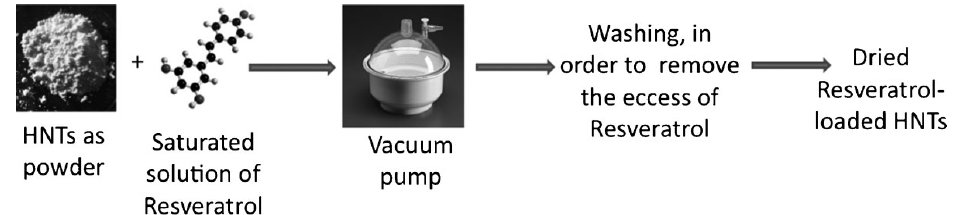
Figure 5. Scheme of the resveratrol loading inside HNTs lumen. Reproduced with permission from [74].